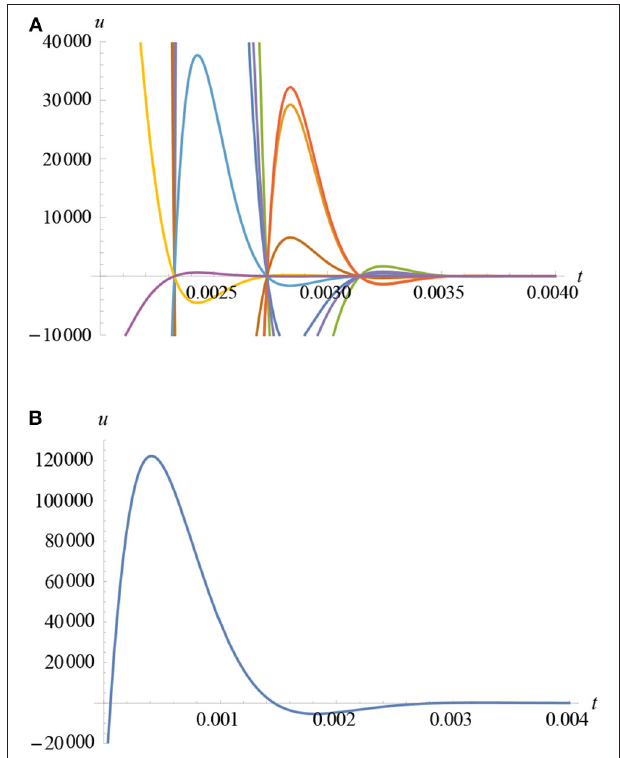
FIGURE 10 | (A) The variation of wave-pressure vs. time for differing wave-velocity: higher velocity waves peak sooner than those of lower velocity (some curves have been omitted for clearer visibility). (B) The variation of wave-pressure vs. time for the superposition of each of the 40 m/s waves in (A) . Here, after the point where the curve first becomes positive, the maximum peak-pressure is 122,192 Pa and the minimum is